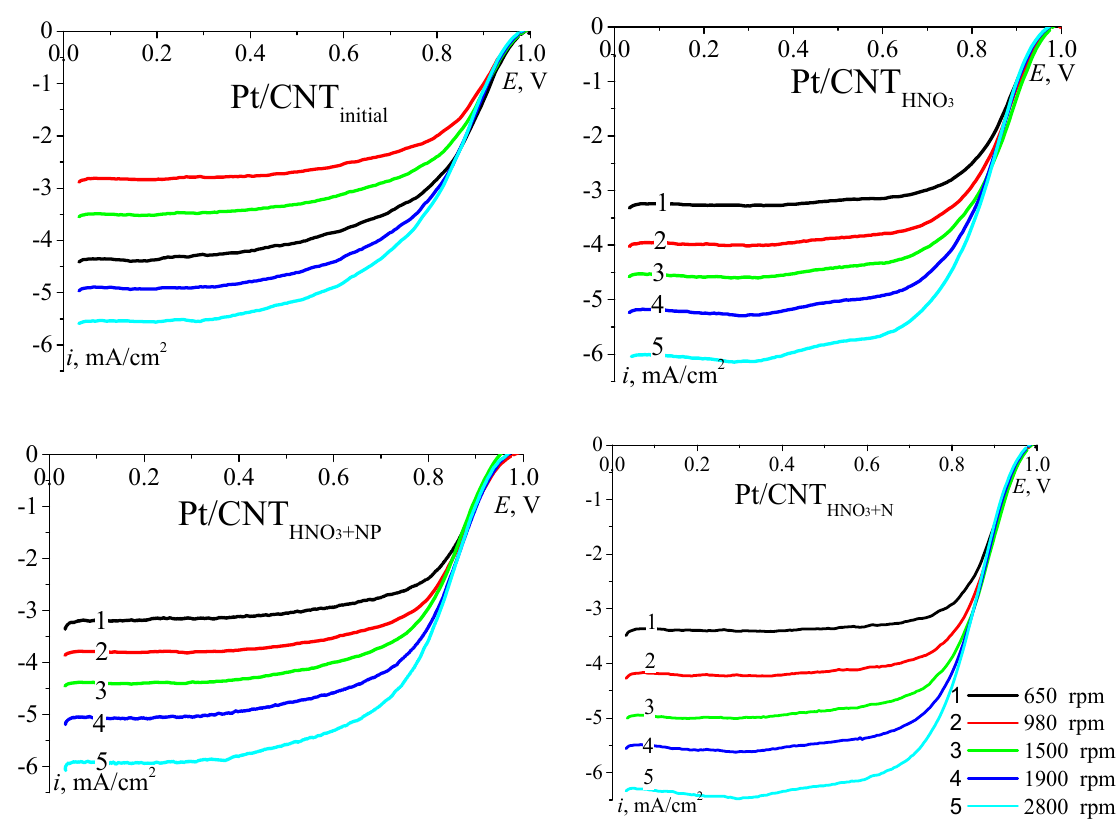
Figure 5. Polarization curves recorded on Pt-catalysts at different electrode rotation rates (indicated in the Figure), O 2 ; 0.1 M KOH, 5 mV/s, m um = 0.15 mg/cm 2.